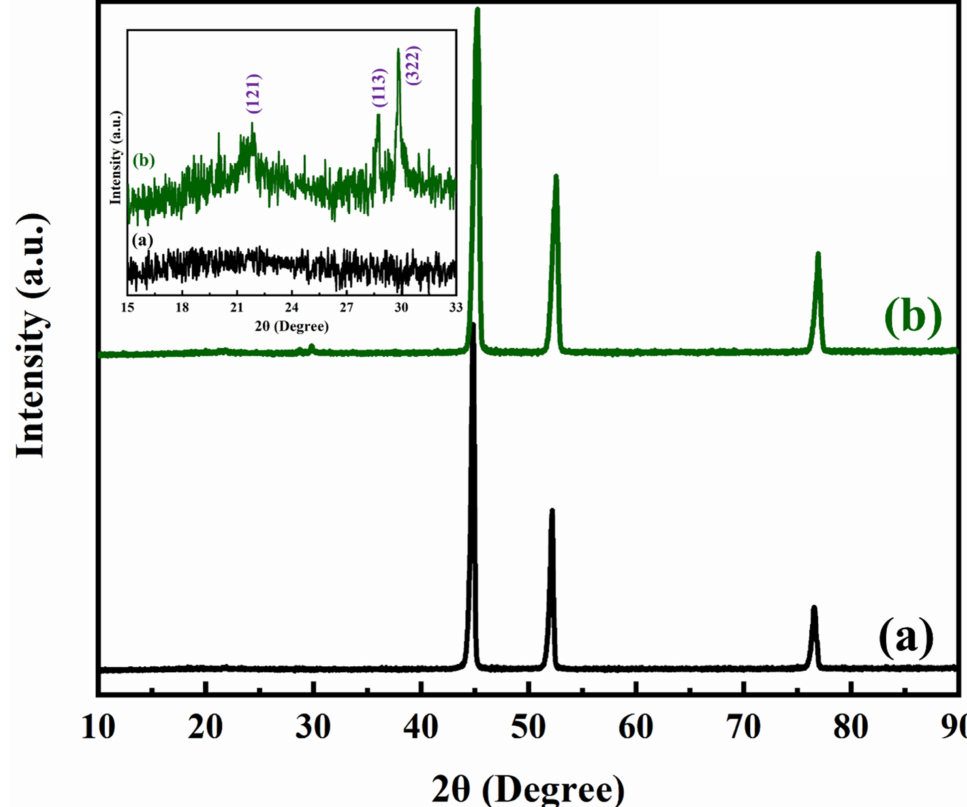
Figure 4. XRD spectrum of ( a ) bare NF and ( b ) PANI/NF. The inset shows an enlarged region overview from 2 θ = 15 ◦ to 33 ◦